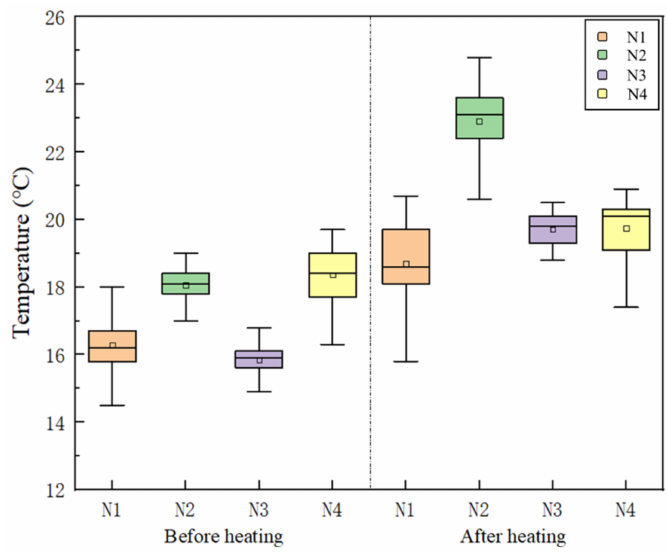
Figure 5. Box diagram of